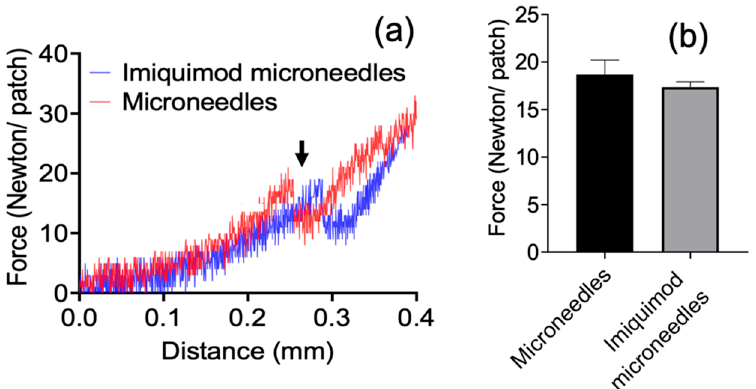
Figure 6. The mechanical failure of gelatin microneedles and with the additional imiquimod-loaded microneedles. The axial failure of imiquimod-loaded microneedles was evaluated by vertically applying forces onto patches. ( a ) the spectrum of microneedles’ mechanical strength; and ( b ) the failure force of microneedles.